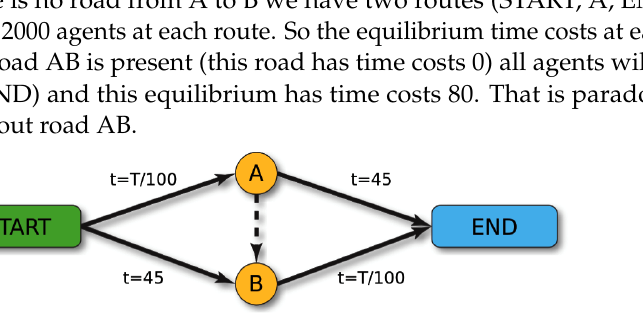
Figure 1. Braess’s paradox graph.